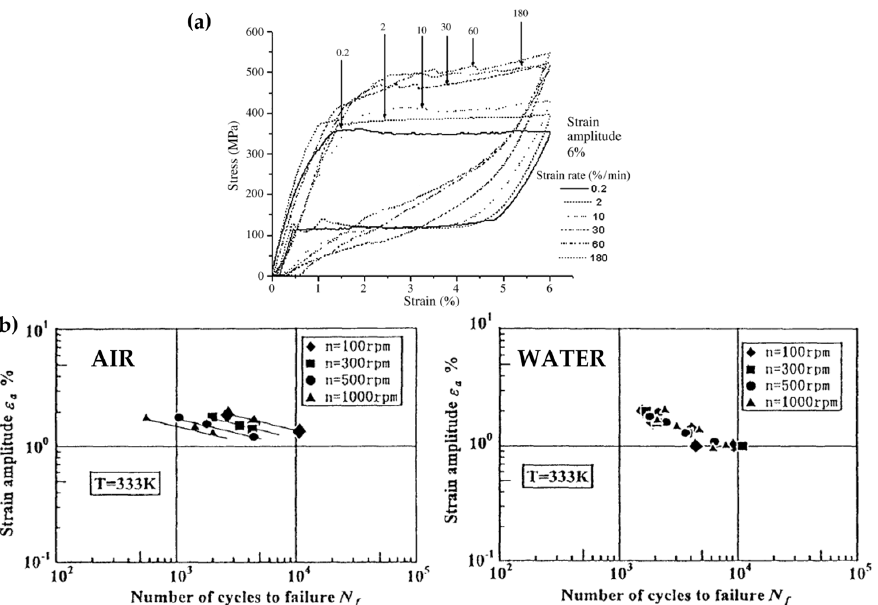
Figure 4. ( a ) Strain rate sensitivity of the stress–strain response of Ni-Ti, reprinted with permission from [43] (Elsevier, 2023). ( b ) Comparison between the strain–life plots at different rotational speeds in air and water, reprinted with permission from [46] (Elsevier, 2023).